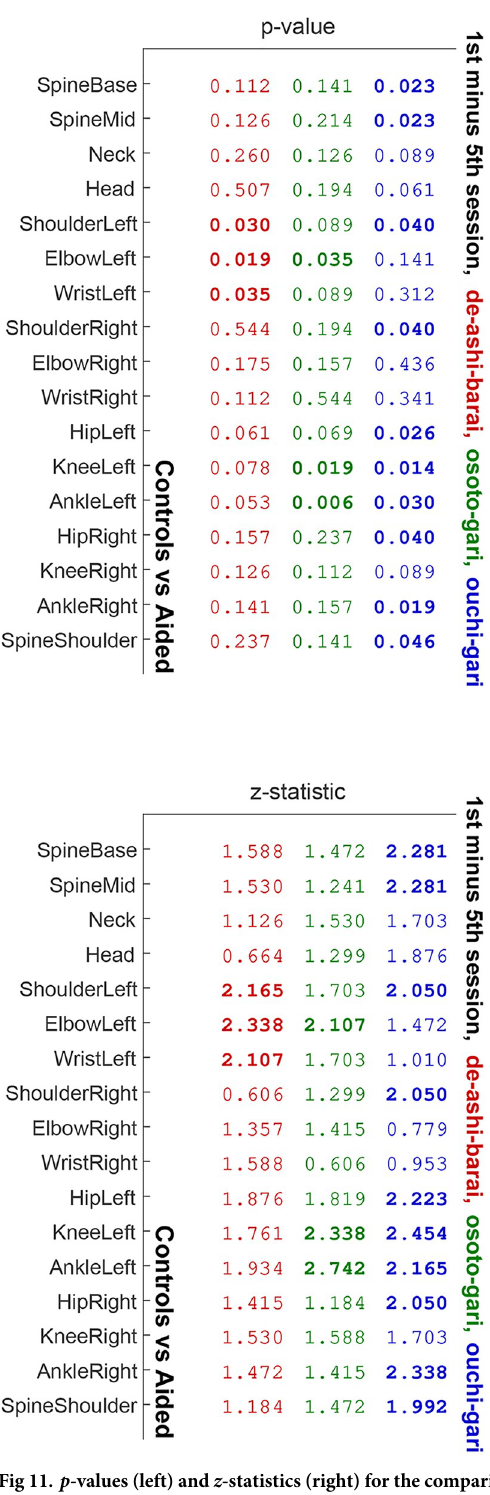
PLOS ONE | https://doi.org/10.1371/journal.pone.0210260 February 6,